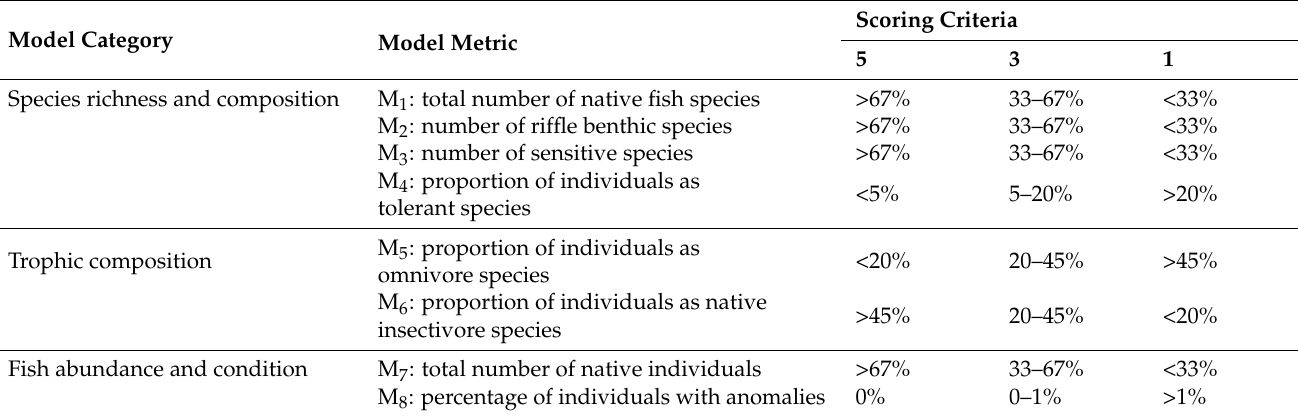
Table 2. Index of biotic integrity (IBI) model and scoring criteria of eight metrics. Model Category Model Metric